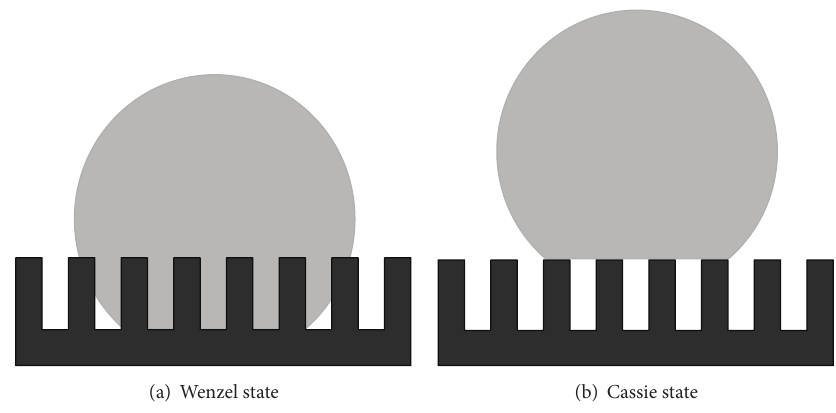
Figure 1: Wetting state of rough surfaces.